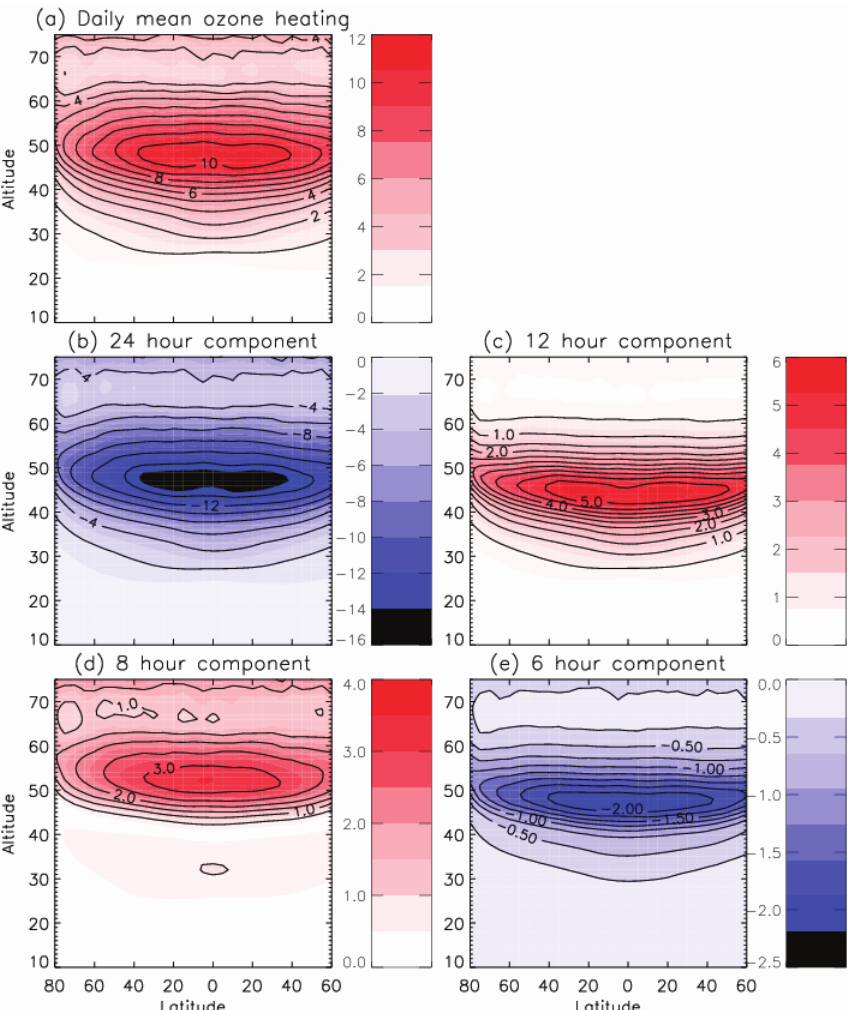
Fig. 6. Latitude-height cross sections of the coefficients of daily mean (a) , diurnal (b) , semidiurnal (c) , terdiurnal (d) , and 6-h (e) components of ozone heating rate at day 80 in